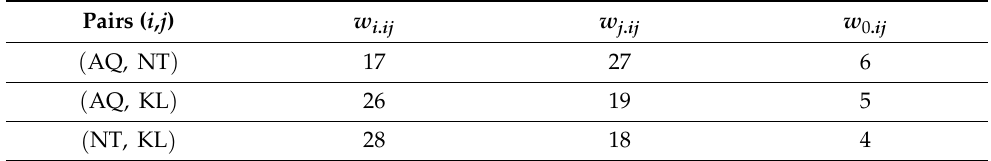
Table 6. Preference counts pairwise choices of the drinking water brands. Pairs ( i , j ) w i . ij ( AQ, NT